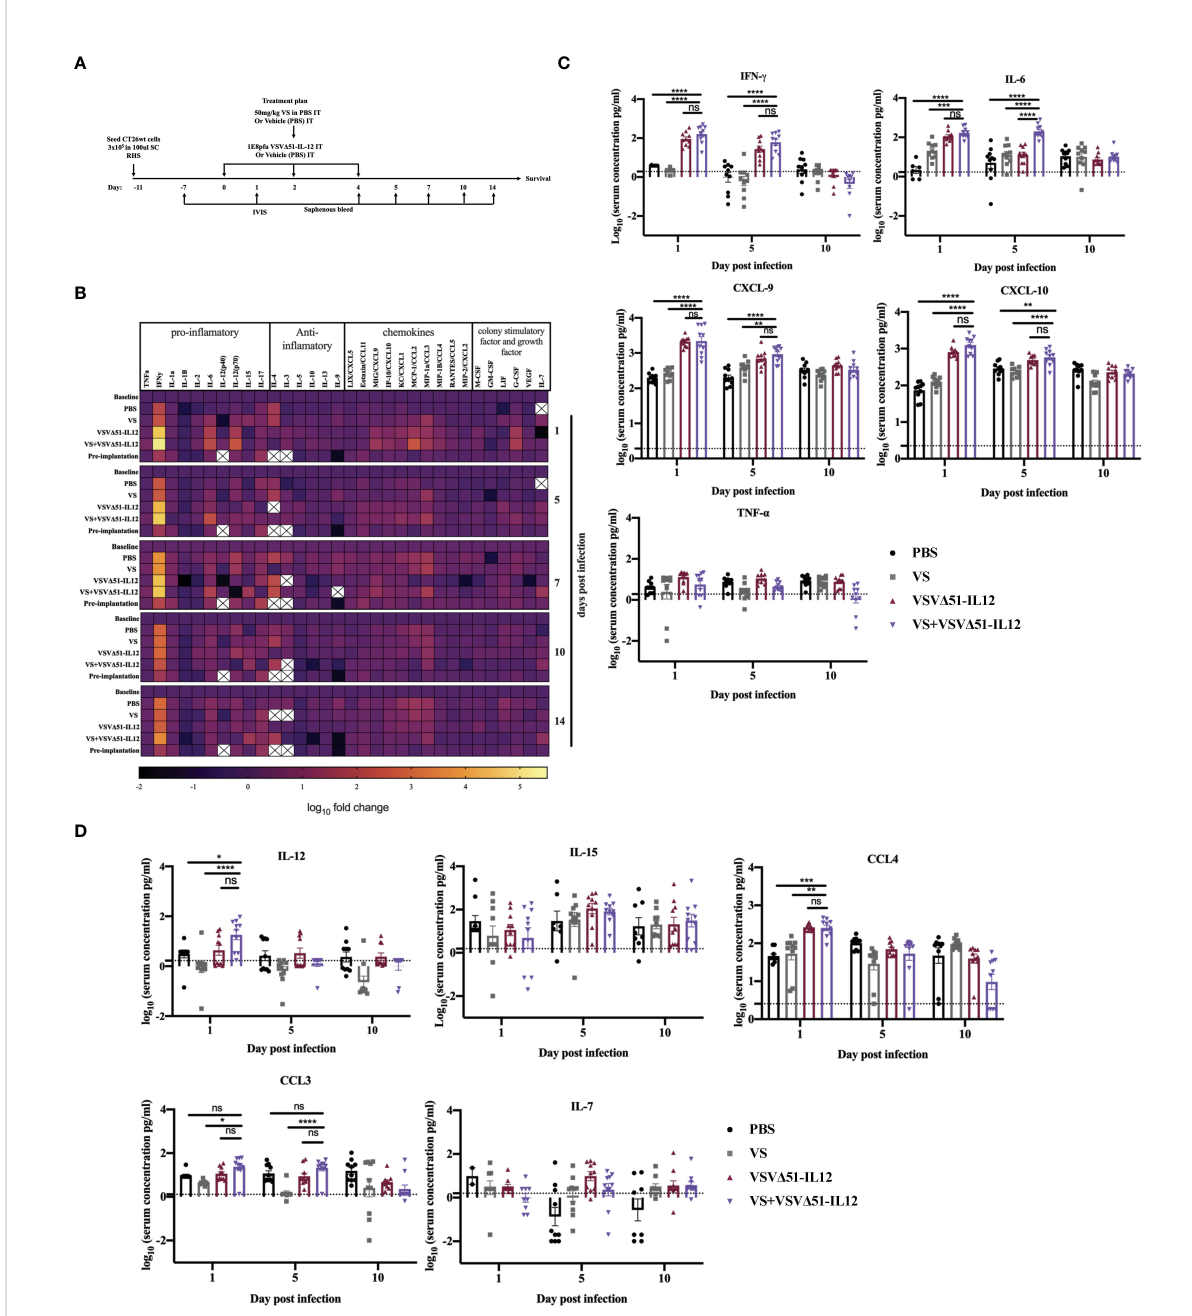
FIGURE 6 VS+VSV D 51 encoding/ expressing IL12 co-treatment further induces the upregulation of the secretion of pro-in fl ammatory chemokines and cytokines 1 day and 5 days post the treatment. (A) CT26WTtumor bearing mice received a total of three doses delivered intratumorally of vanadyl sulfate (50mg/kg) and VSV D 51 expressing IL-12 (1E8 PFU) or with PBS, vanadyl sulfate (50mg/ kg), or VSV D 51 expressing IL-12 (1E8 PFU) alone over 5 days. (B) Heatmap of the log 10 fold change per condition of pooled sera, normalized to day 7 post implantation as baseline for all the tested time points. (C, D) The concentration of cytokines and chemokines pg/ml for each group for each individual mouse (n=10 per condition) was presented in each graph. Data transformed into Log 10 , line indicated the detection concentration, Mean ± SEM; * P = 0.01, ** P = 0.003, *** P = 0.001, ****P < 0.0001, Two-way ANOVA. ns=not signi fi